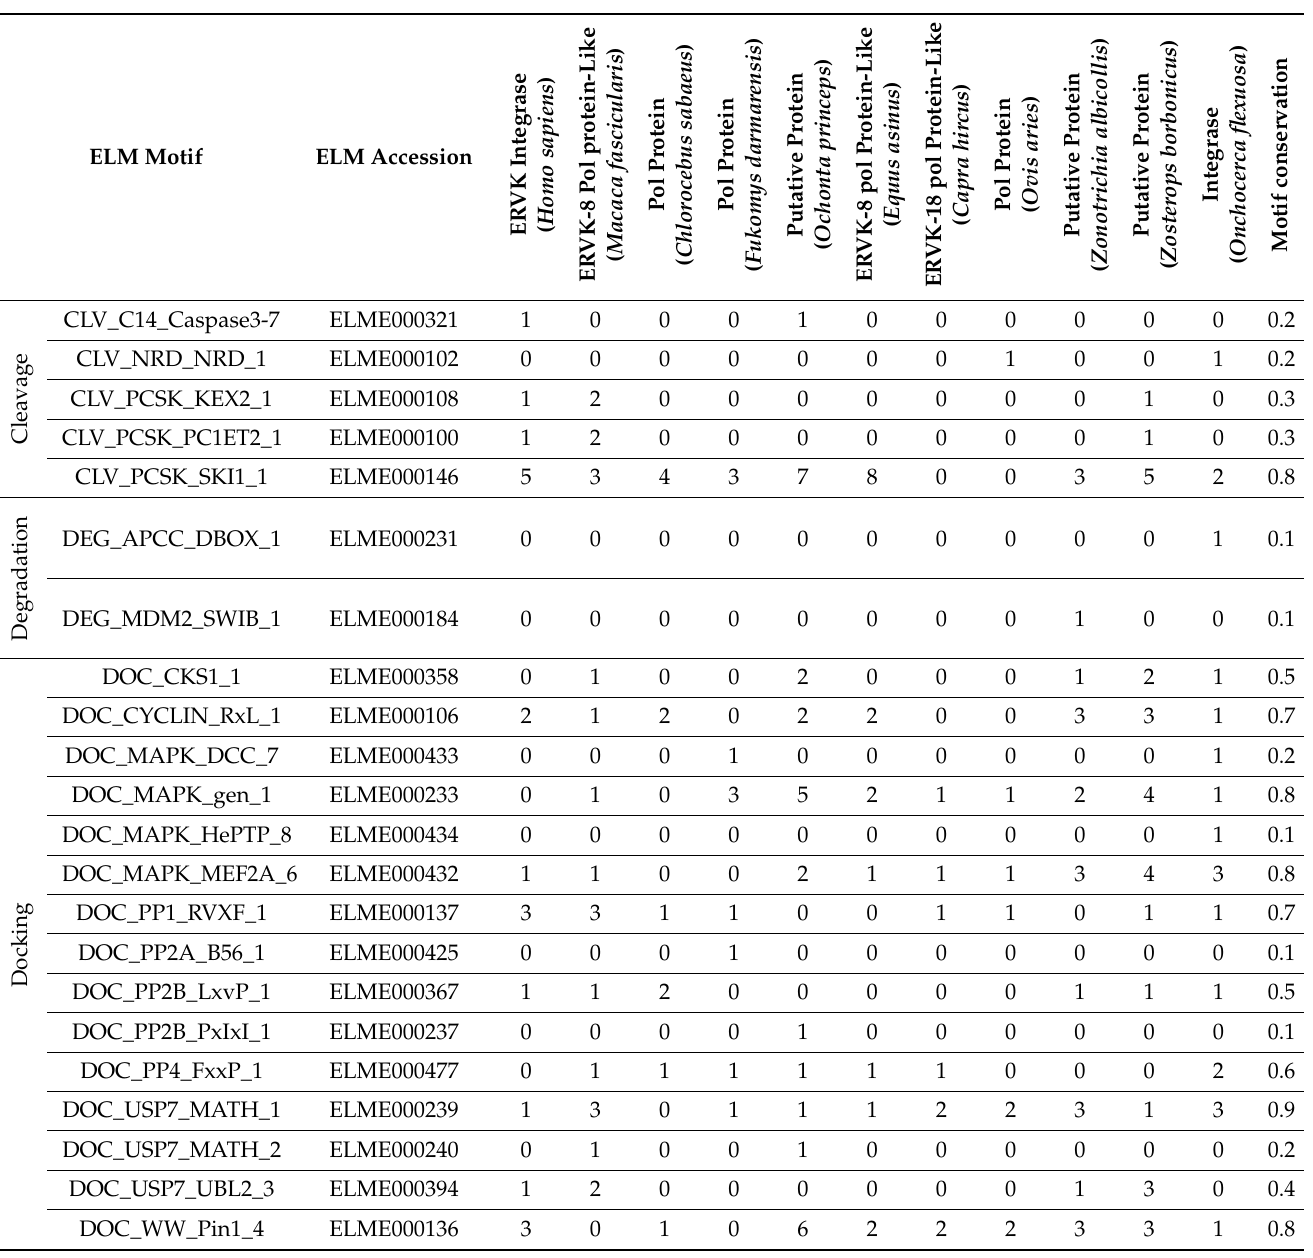
Table 2. ELM motifs in ERVK integrase and similar endogenous integrases in